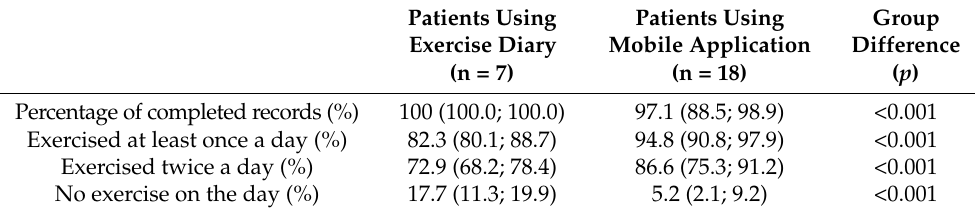
Table 2. Adherence to home-based rehabilitation programme (patients who completed the